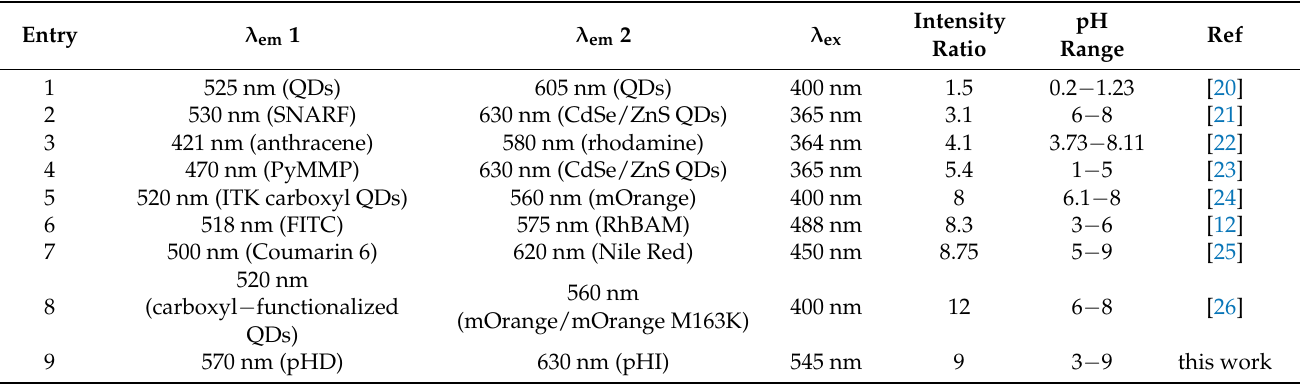
Table 1. Ratiometric nanosensors based on two probes with opposite pH − responding direction.